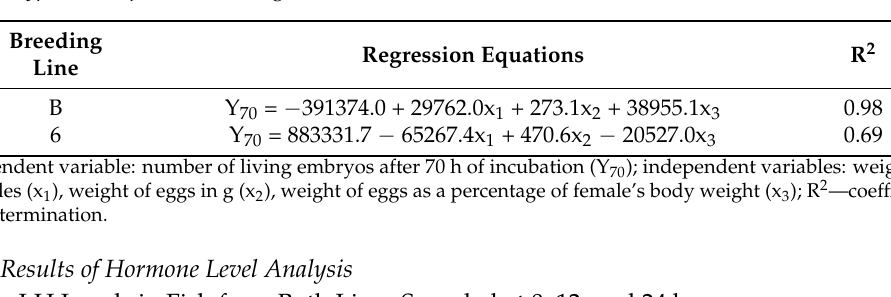
Table 3. Regression predictions for the number of living embryos after 70 h of incubation for common carp ( Cyprinus carpio L.) breeding lines B and